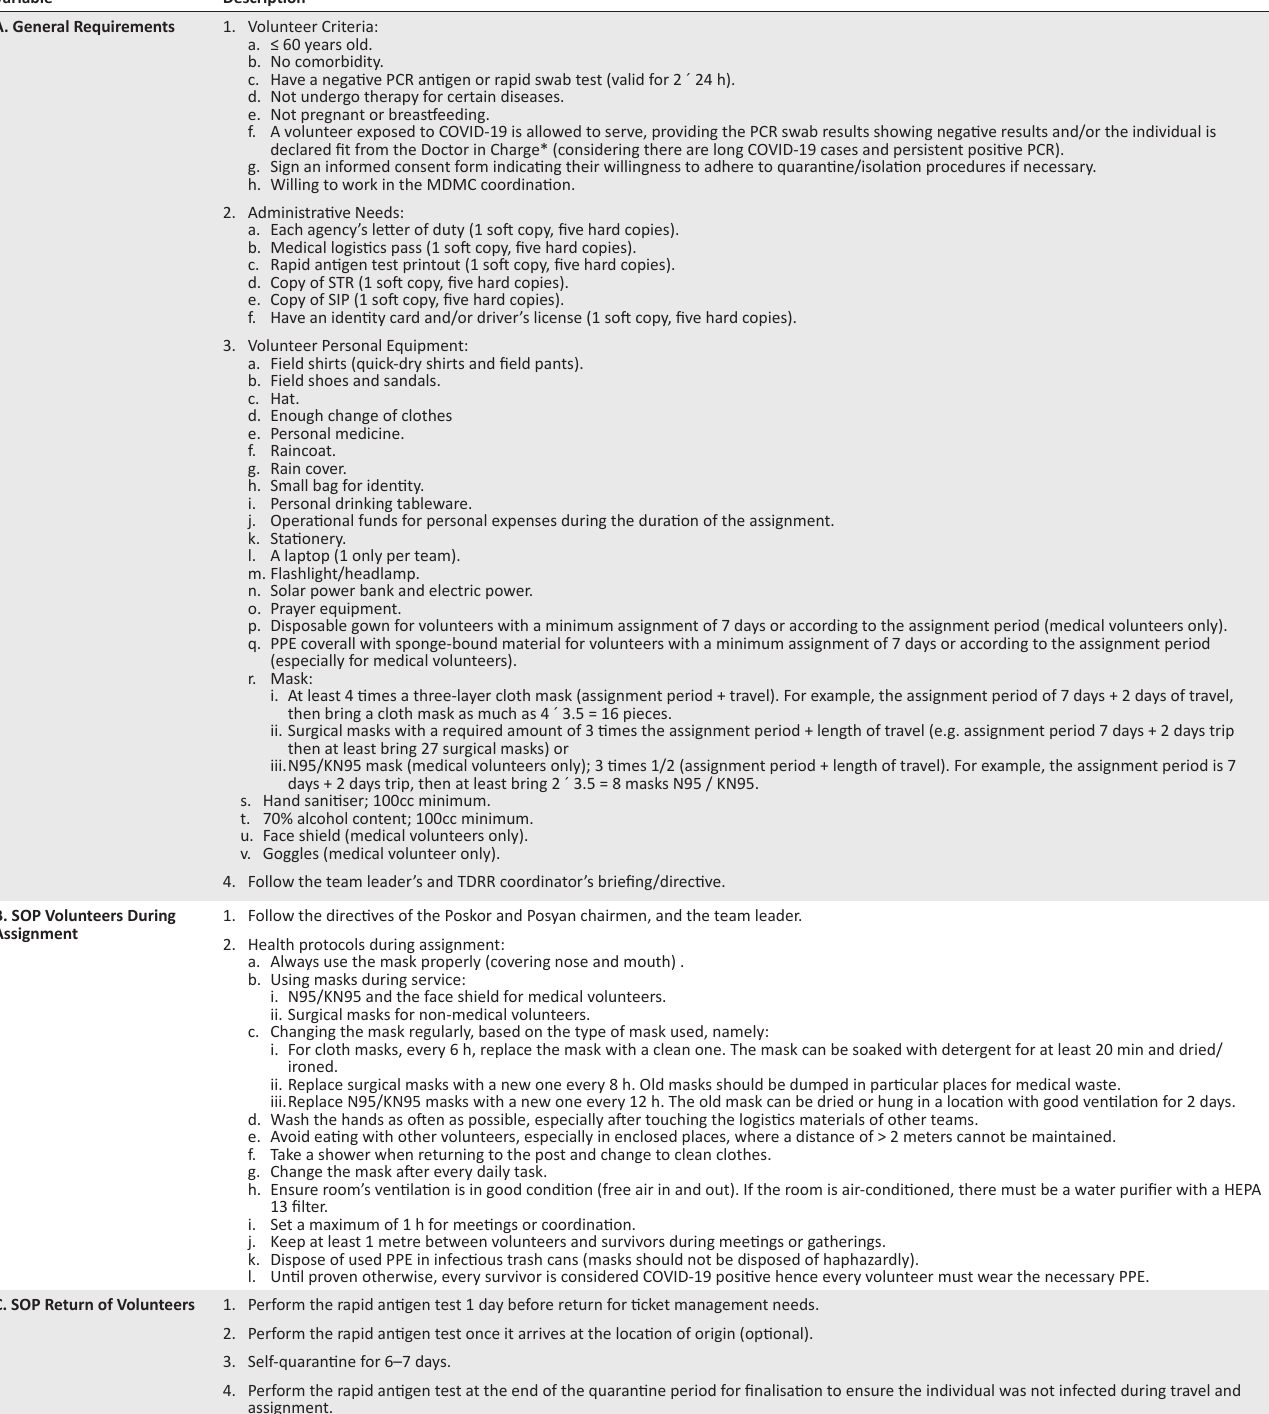
TABLE 2: Standard operational procedure for the assignment of Muhammadiyah volunteers during the COVID-19 pandemic.